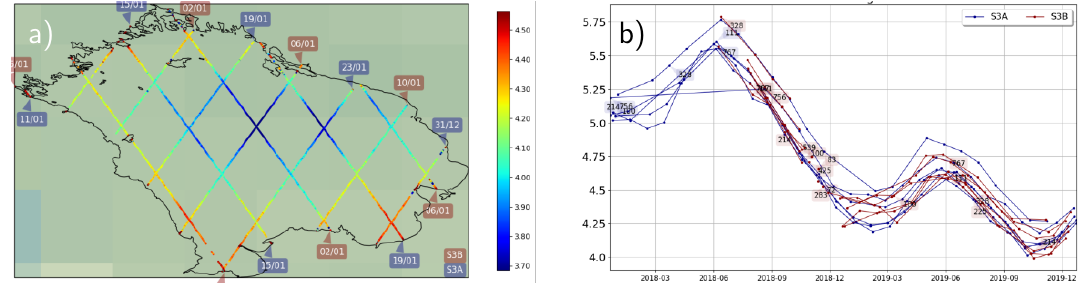
Figure 48. Monitoring of water levels in Lake Ladoga ( a ) Map showing WSH (m) measured along different S3A and S3B tracks ( b ) Time series for each track, specified by pass number (S3A in blue, S3B in red. During its tandem mission (Jul.–Oct. 2018) S3B flew the same tracks as S3A; after Nov. 23th 2018 S3B was in it final interleaved orbit.